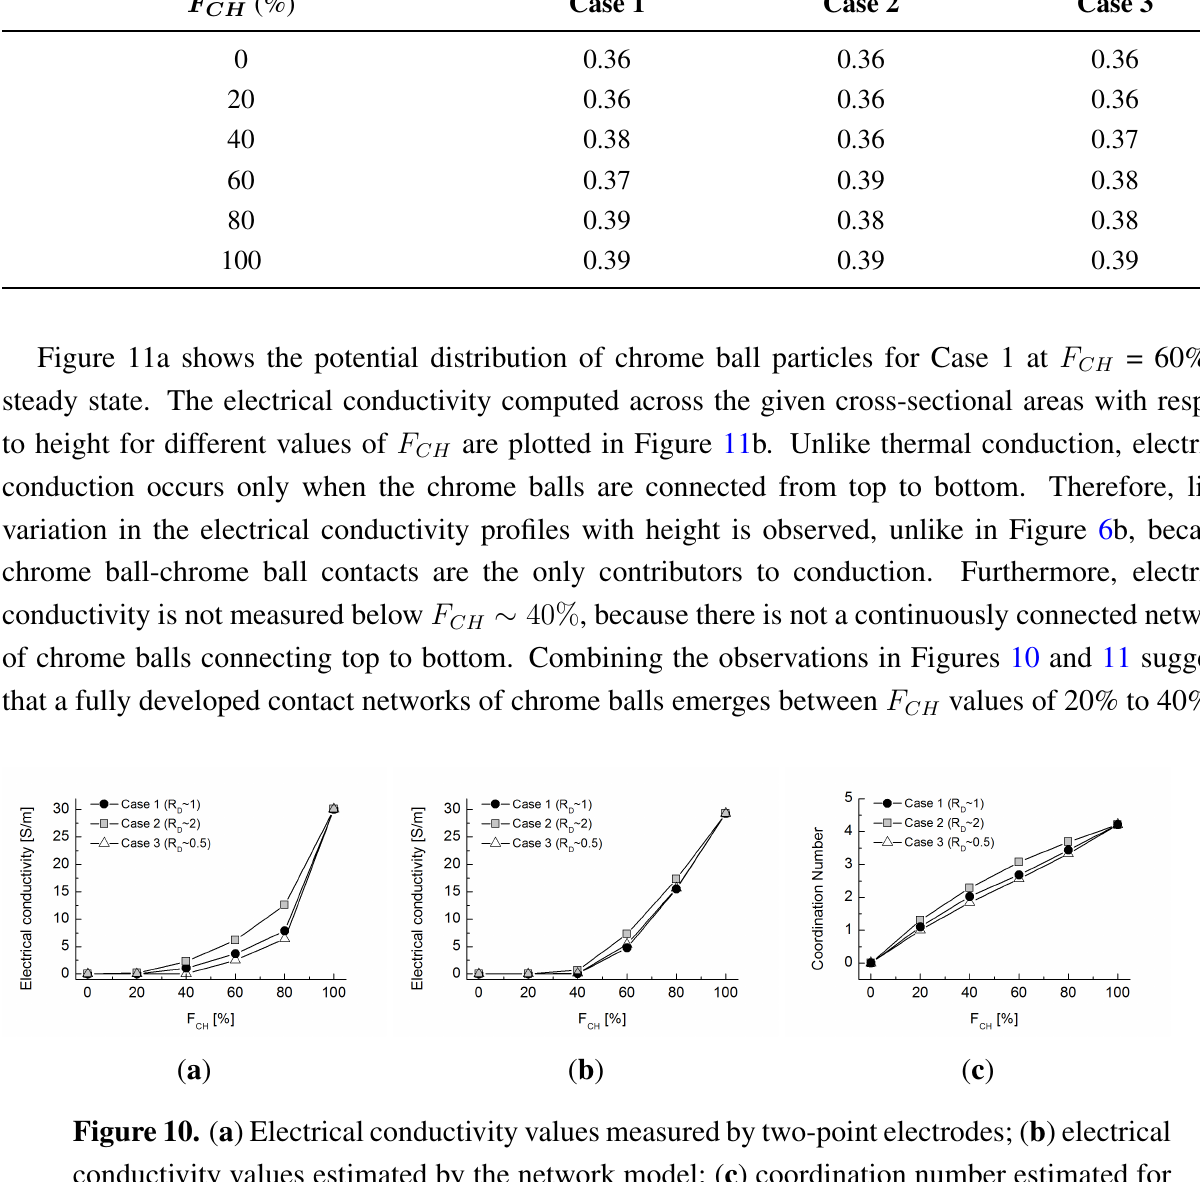
Table 6. Volumetric fraction and porosity of chrome ball-glass bead mixture. Vol. Fraction,